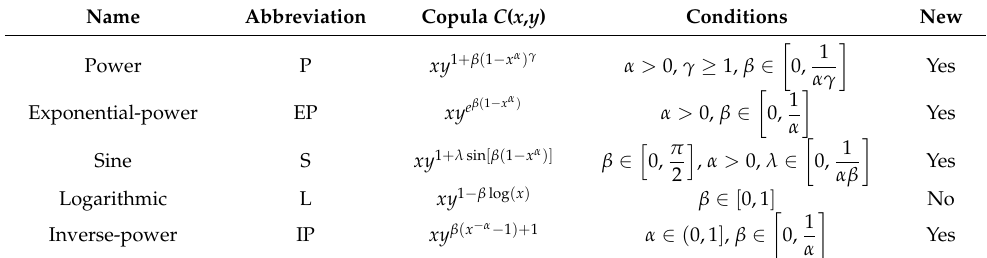
Table 1. Copulas derived from Theorem 1 and Lemma